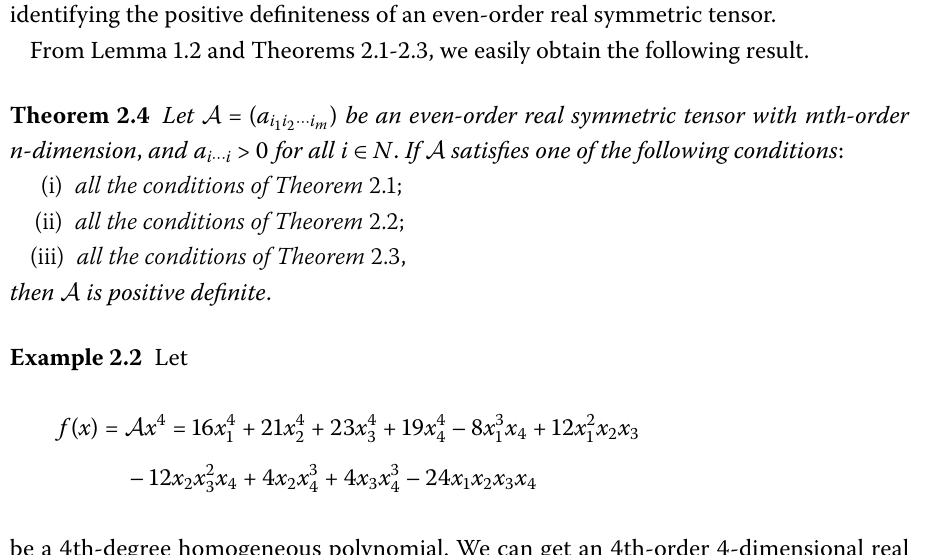
and h ( l +1) ( i ∈ { 2,3,4 } )